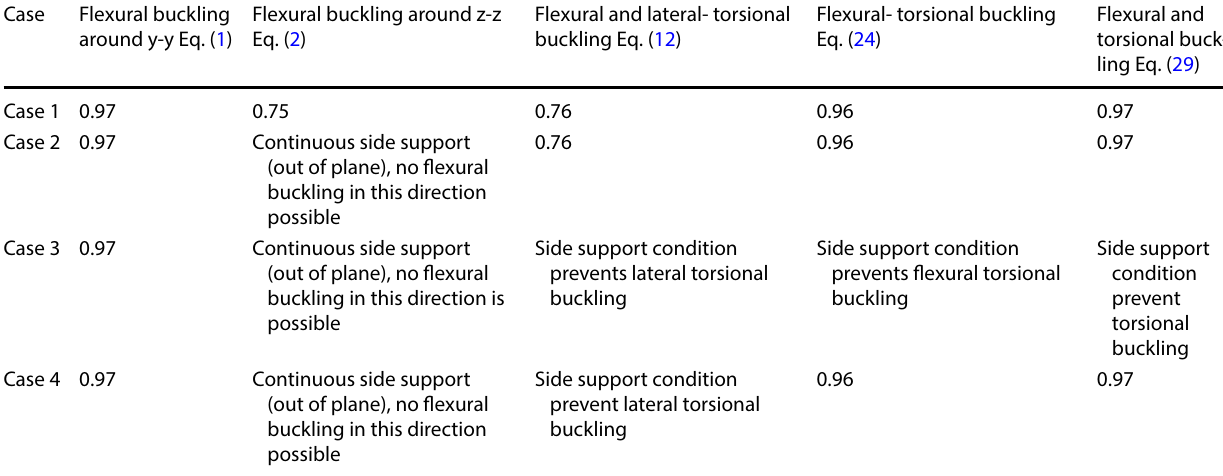
Table 6 The effect of lateral supports on beam stability. Beam dimension 810 × 140, strength class GL32c Case